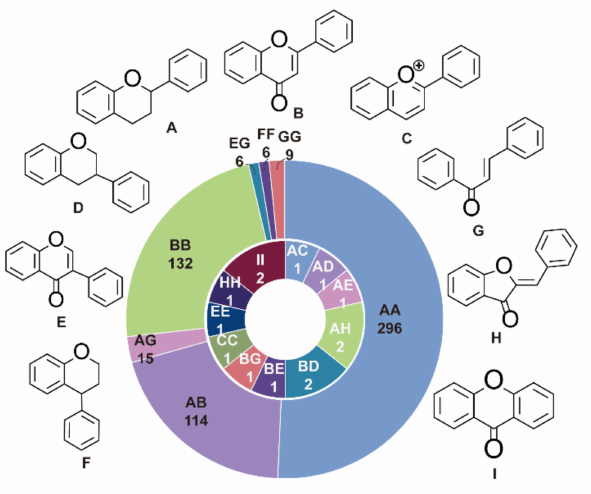
Figure 1. The scaffold of